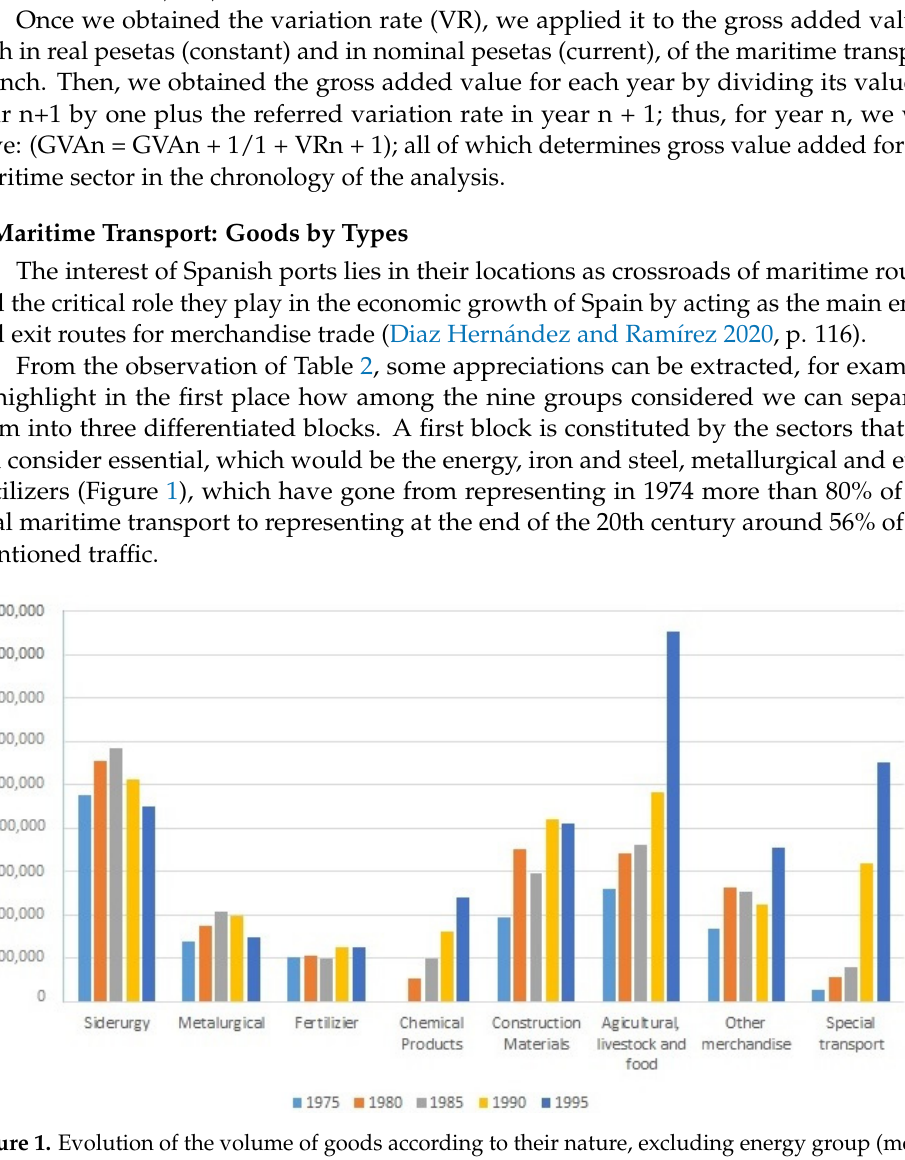
Figure 1. Evolution of the volume of goods according to their nature, excluding energy group (met- tons). Source: own elaboration based on the annual reports of Ente P ú blico Puertos del Estado, using ric tons) . Source: own elaboration based on the annual reports of Ente Público Puertos del Estado, data from Table using data from Table 2.